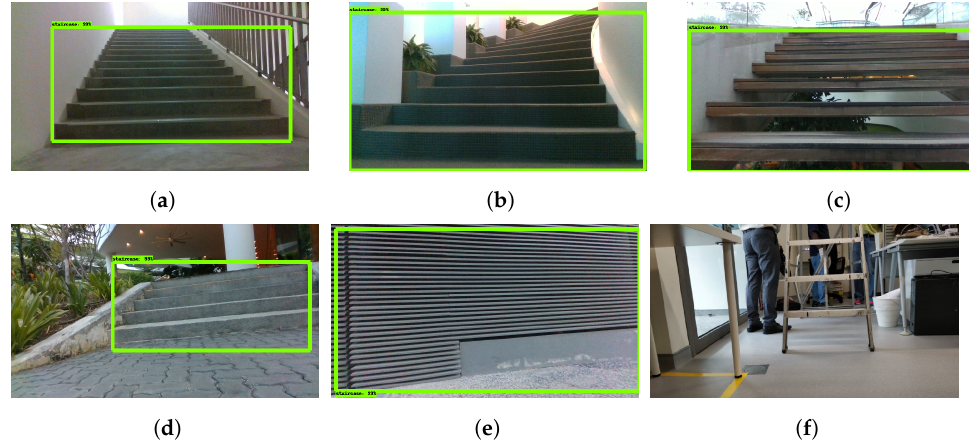
Figure 11. SSD MobileNet Staircase Detection Results. ( a – d ) Correct detections of staircases. ( e ) False detection as staircase. ( f ) Ladders not detected.